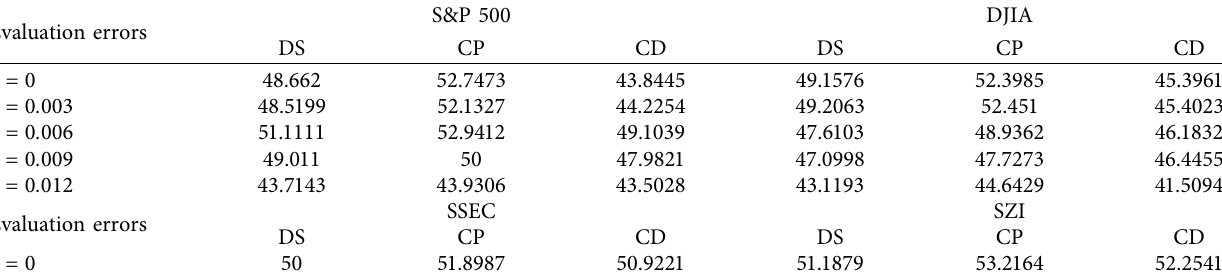
Table 6: Trend-type forecasting evaluation of the FM-Elman ( k � 3) model as threshold value θ